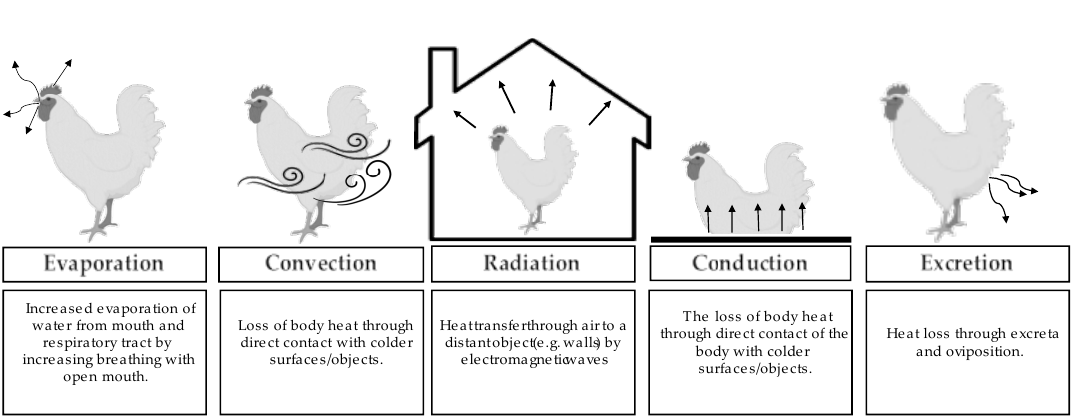
Figure 1. Definition and illustration of the thermoregulation mechanisms five (evaporation, convection, radiation, conduction, and excretion) of body heat in poultry.